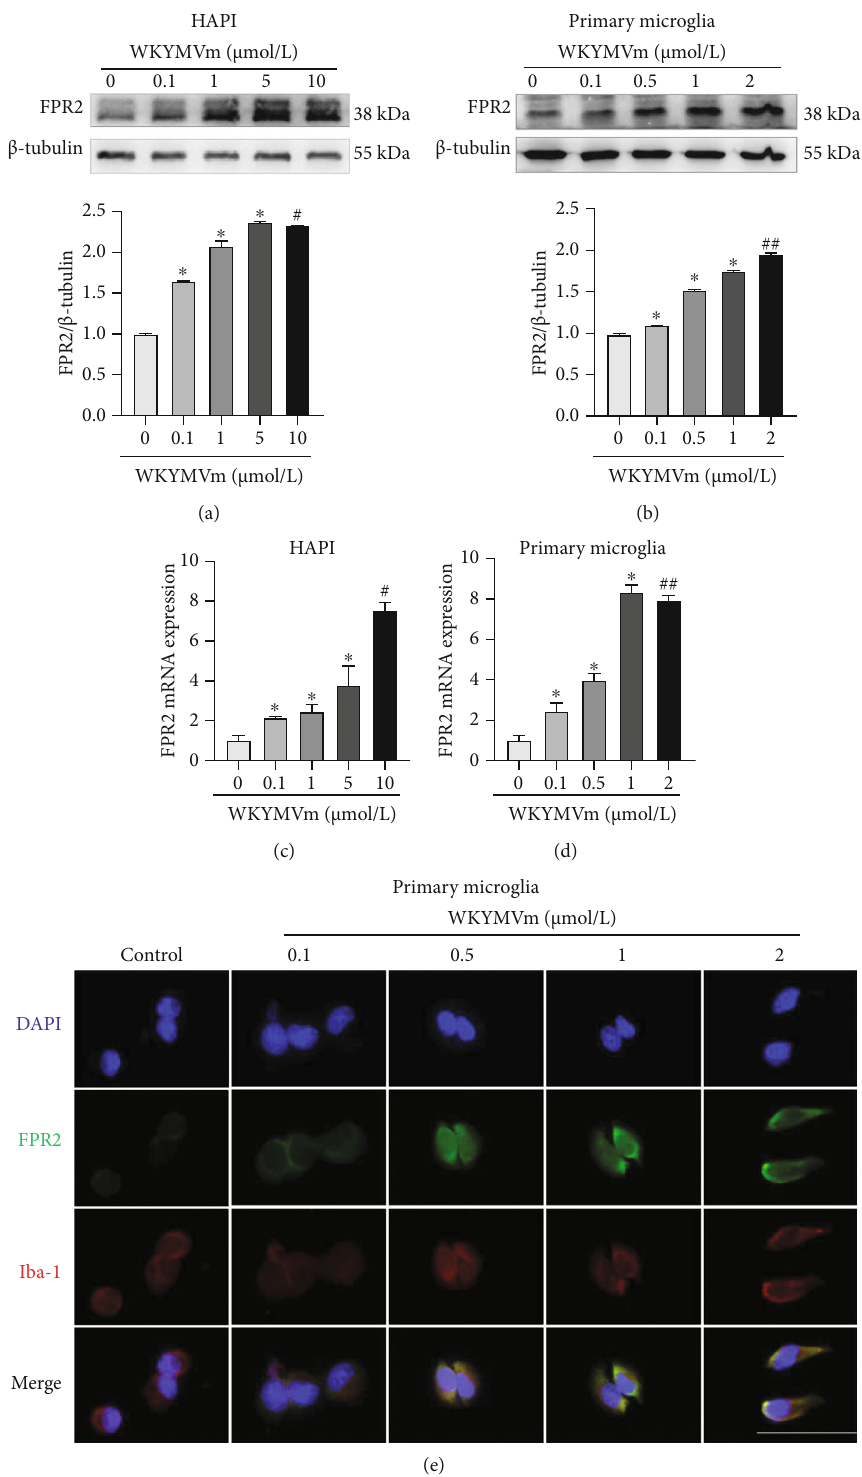
Figure 2: WKYMVm promoted the expression of FPR2 in microglial cells. (a, b) Western blots and quantitative data for FPR2 expression in HAPI microglia and primary microglia stimulated by di ff erent concentrations of WKYMVm. (c, d) FPR2 mRNA levels in HAPI microglia and primary microglia are stimulated by di ff erent concentrations of WKYMVm. (e) Immuno fl uorescence staining for FPR2 in primary microglia stimulated by WKYMVm with concentrations from 0 to 2 μ mol/l. scale bar: 50 μ m. ∗ p < 0 : 05 vs. the control group; # p < 0 : 05 vs. the 5 μ mol/l WKYMVm group; ## p < 0 : 05 vs. the 1 μ mol/l WKYMVm